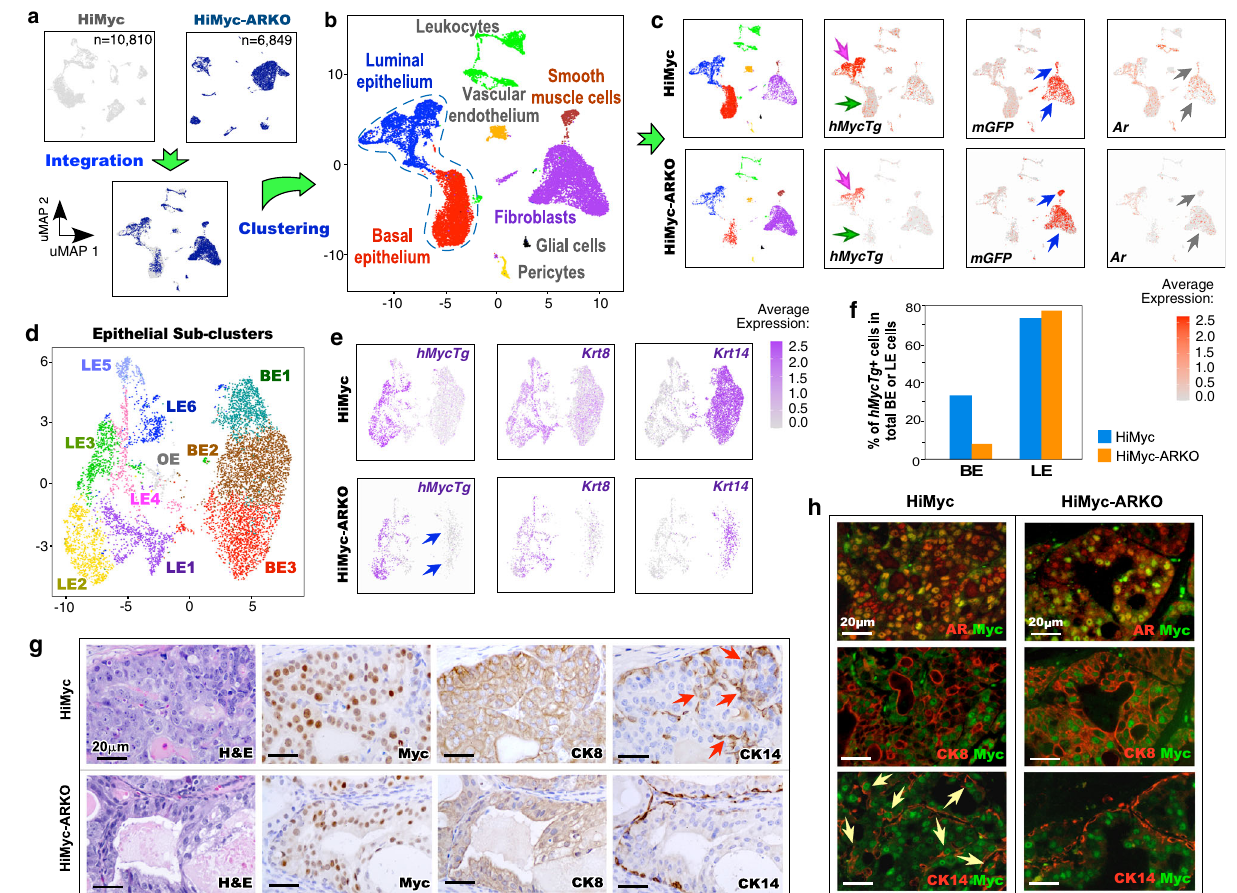
d UMAP visualization of epithelial cells sub-clustered, re-clustered, and labeled by cell type. BE, basal epithelial cells; LE, luminal epithelial cells; OE, other epithelial cells. e Gene expression levels of markers for human Myc transgene ( hMycTg ), LE ( Krt8 ), and BE ( Krt14 ). f Graph showing the percentage of hMycTg + cells per total basal or luminal cells in each genotype. Source data are provided as a Source Data fi le. g RepresentativeimagesofH&Eand IHCstaining forMyc,cytokeratin8(CK8), and cytokeratin 14 (CK14) in adjacent prostate tissue sections of 3-month-old Hi- Myc:R26 mTmG/+ :Gli1 CreER/+ (top) and Hi-Myc:R26 mTmG/+ :Ar L/Y :Gli1 CreER/+ (bottom) mice. Scale bars, 20 μ m. Red arrows indicate CK14 + cells in fi ltrating towards the lumen. h Colocalization of Myc with either AR, CK8, or CK14 from indicated prostate tissues. Yellow arrows indicate Myc + CK14 + cells. Scale bars, 20 μ